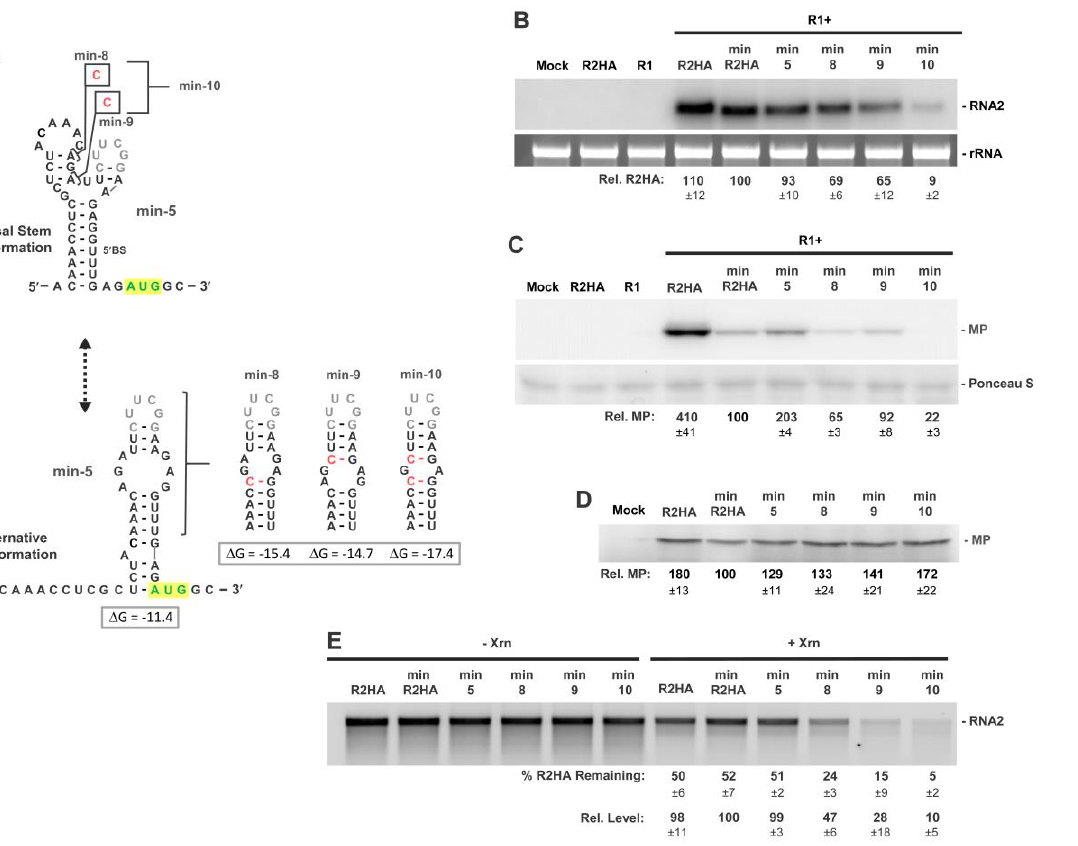
Figure 7. RNA2 minimal 5 ′ UTR mutants assessing stabilization of the alternative conformation. ( A ) RNA secondary structures for the two proposed conformations in min-R2. Substitutions designed to shift the equilibrium toward the alternative conformation are shown in red, with predicted free energy values below. ( B ) Northern blot analysis of protoplast infections of wt RNA1 (R1) and RNA2 mutants. ( C ) Corresponding Western blot analysis of protoplast infections depicted in panel ( B ). ( D ) In vitro translation in wheat germ lysate of min-R2HA and mutants. ( E ) In vitro Xrn1 treatment of min-R2HA and mutants. Values generated as described in legend of Figure 3.